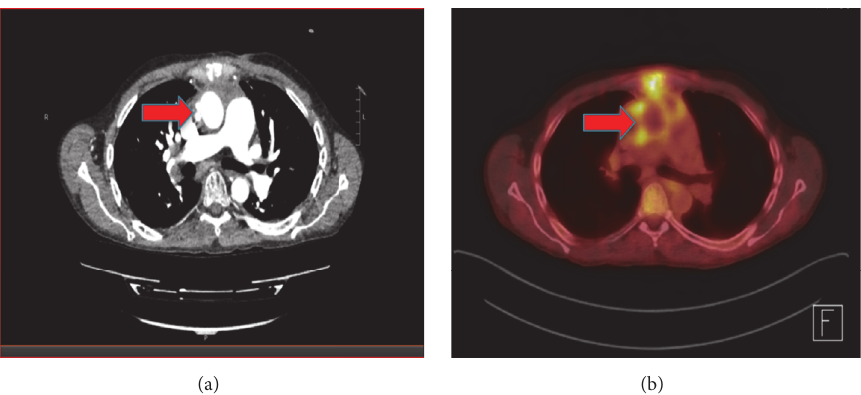
Figure 1: Cross-sectional views of CT angiogram image (a) and PET image (b) of the patient’s chest, showing two outpouchings in the wall of ascending aorta (pointed by red arrows) which were FDG avid on the PET, indicative of mycotic